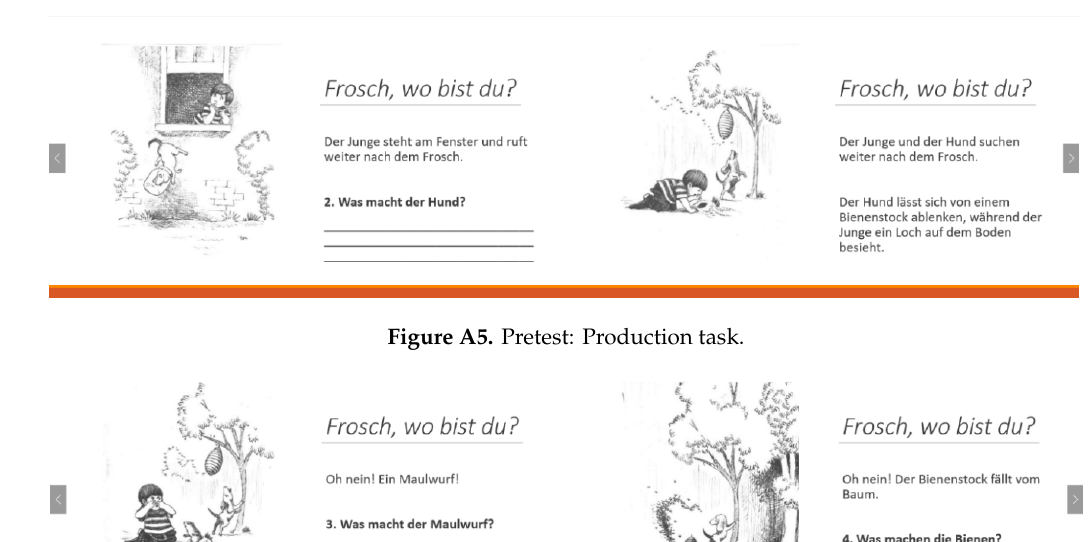
Figure A4. Pretest: Production task.